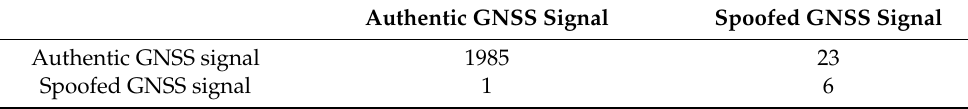
Table 5. Confusion matrix for the independent spoofing validation dataset in Experiment